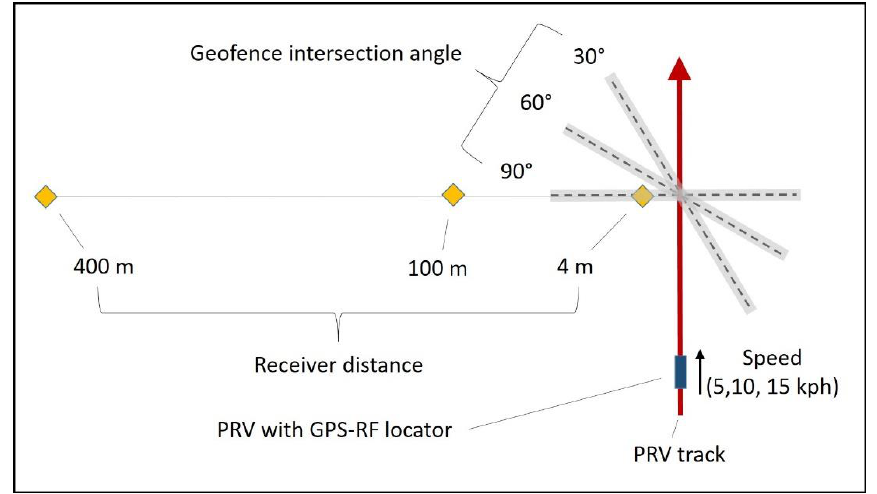
Figure 1. Experimental track, geofences (gray, dashed lines), and receiver locations (gold diamonds). Positions are not to scale. The portable recreational vehicle (PRV) with position tracking traveled from magnetic West to East. All distances and angles were measured using a total station.